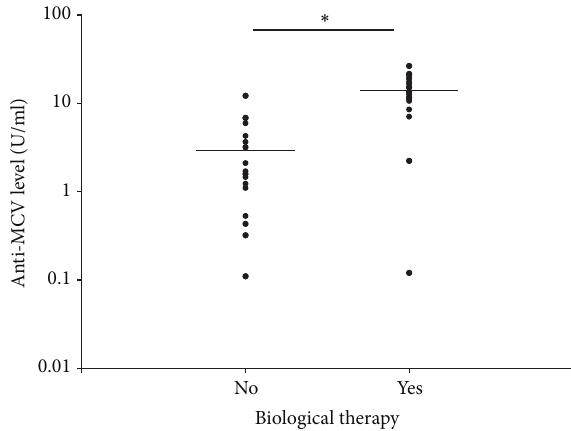
Figure 5: The anti-MCV levels in PsA patients with painful knees are significantly higher than in patients without painful knee. The plots show the antibody in PsA patients without pain of knees (labelled as “No”) and with pain of knees (labelled as “Yes”). The horizontal lines indicate the mean levels of anti-MCVs. ∗ The difference between the anti-MCV levels in the two groups ( 13.87 ± 20.22 U/mL versus 61.18±133.76 U/mL) was significant ( 𝑃 < 0.05 ).